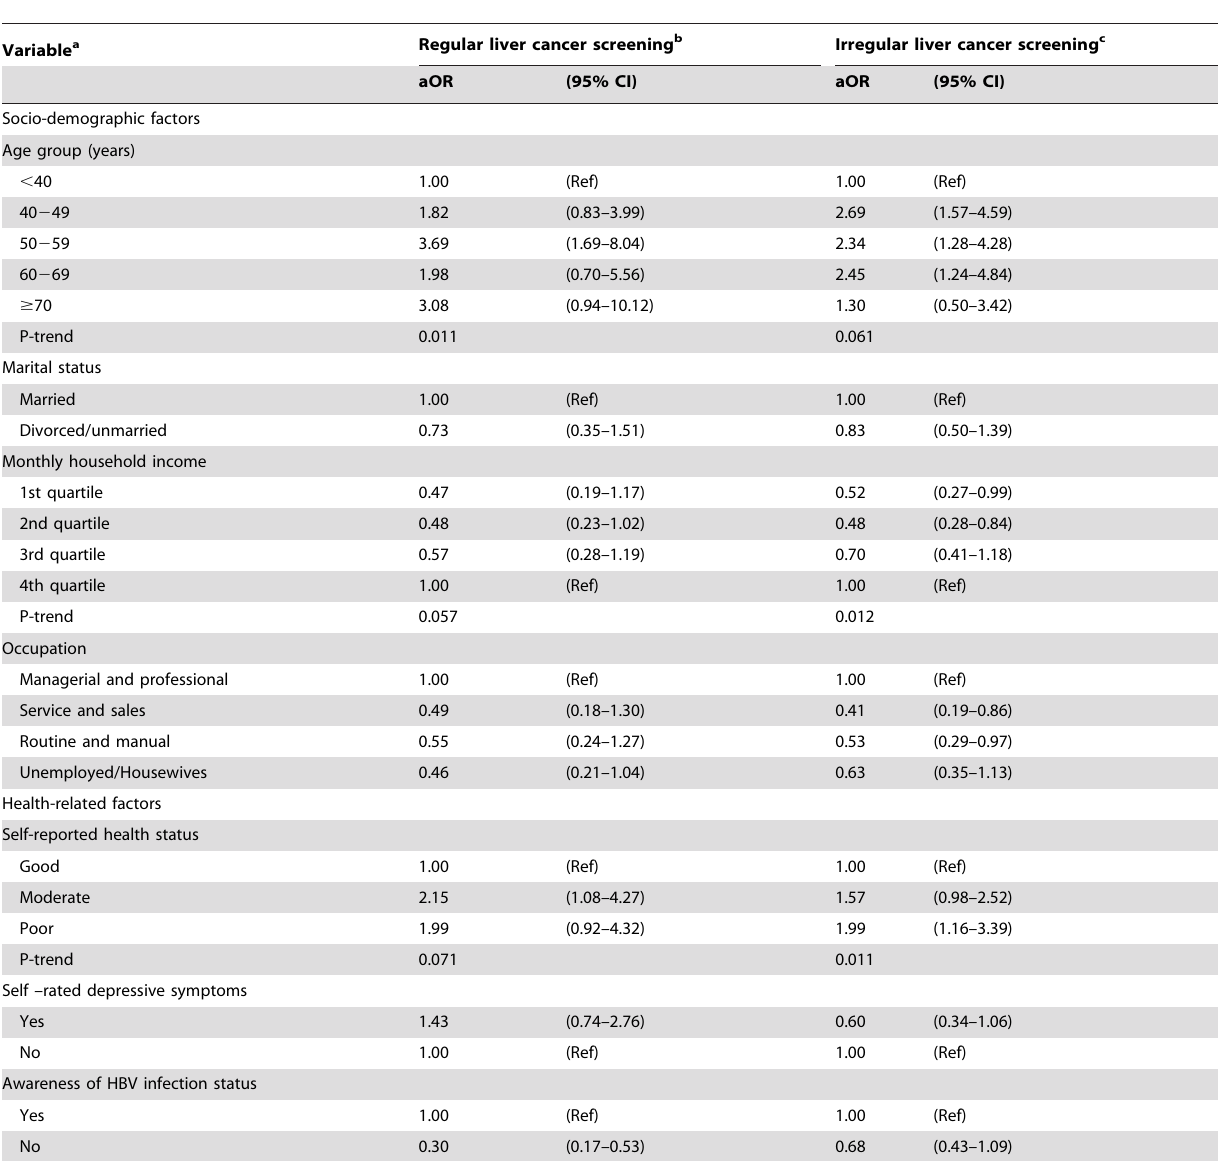
Table 2. Factors associated with regular (in previous 6 months) and irregular liver cancer screening compared to never-screening by polychotomous logistic